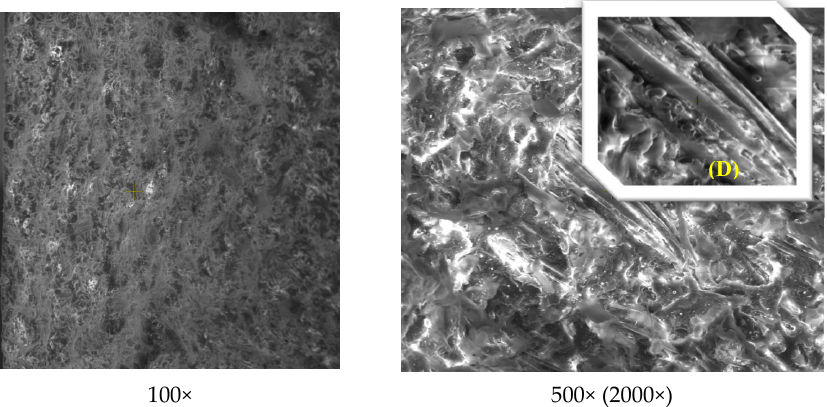
Figure 14. SEM images at different magnification powers for Arboform ® LV3 Nature. Figure 15 highlights the presence of aramid fiber imprints in the biopolymer matrix, with good dispersion and interfacial bonding.